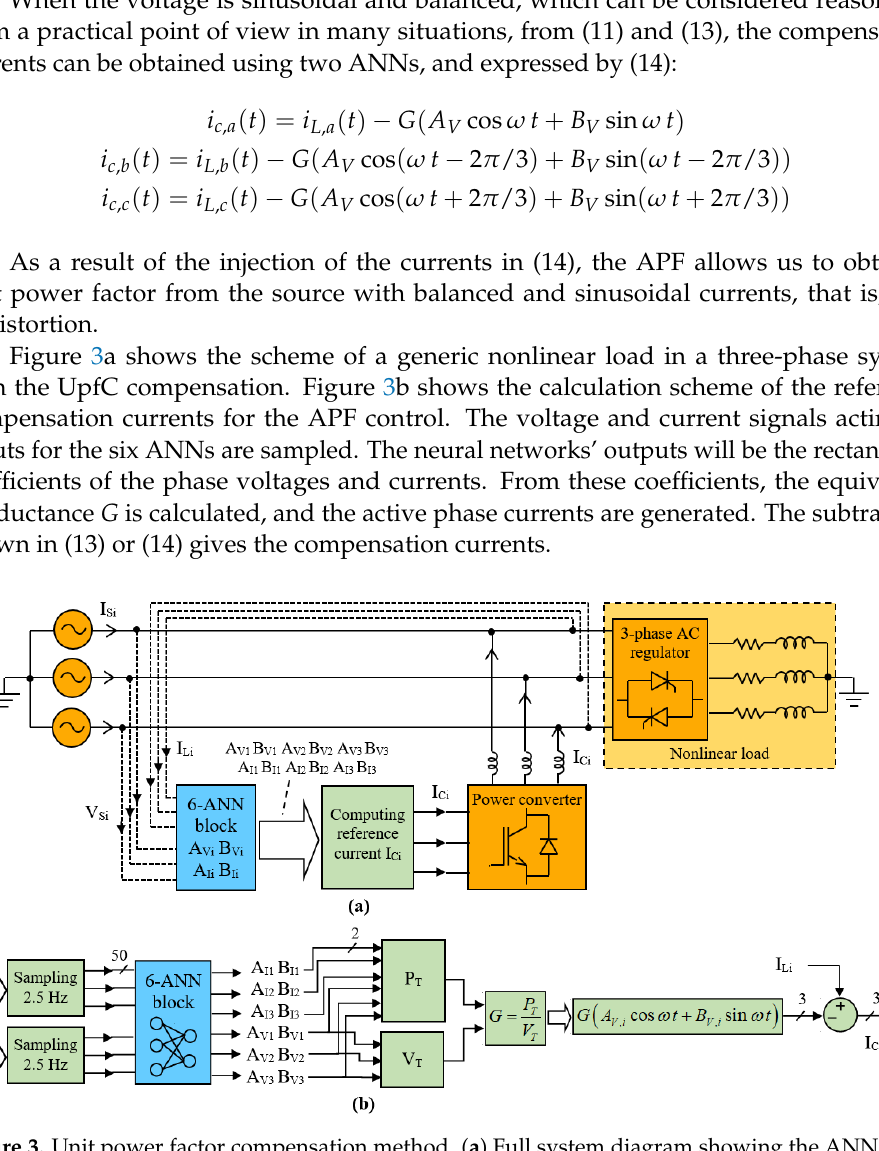
Figure 3. Unit power factor compensation method. ( a ) Full system diagram showing the ANN block estimating the rectangular coefficients. ( b ) Details of the control method, where the computation of the equivalent conductance G allows to generate the active phase currents and the reference waveforms for the compensation currents.